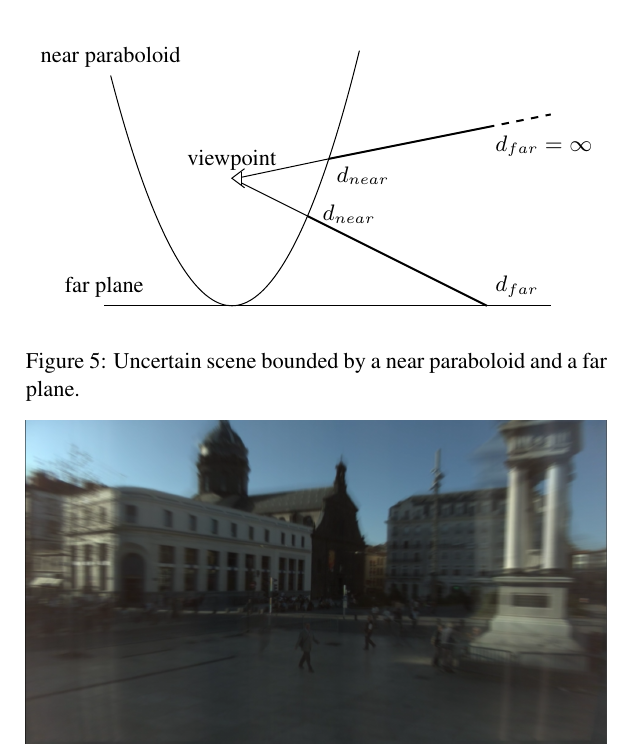
Figure 6: Screenshot of the accompanying video sequence.